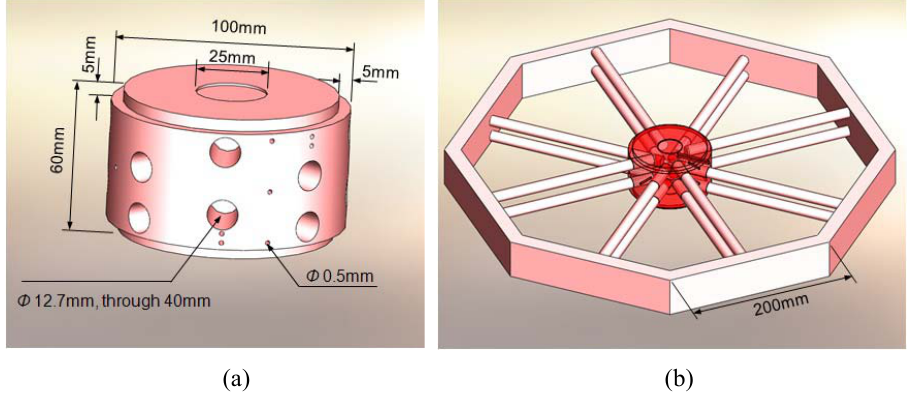
Fig. 2 Test assembly of cartridge heaters, thermocouples and test block: (a) test block fabrication; (b) assembly